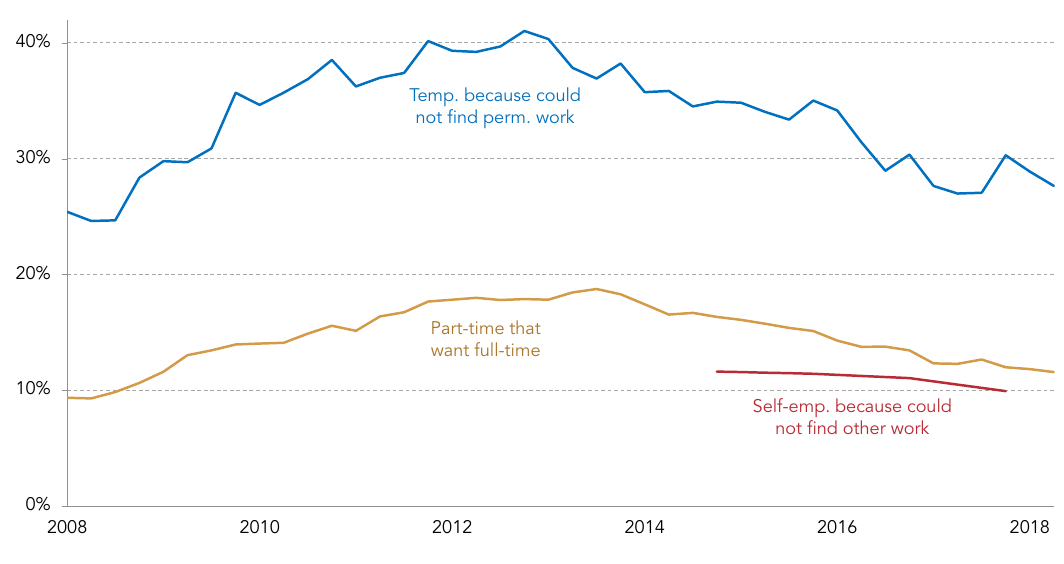
Figure 37: Post-recession, there was an increase in the proportion of people doing atypical work not as a first choice Proportion of those in selected atypical employment categories expressing dissatisfaction, 18-69 year